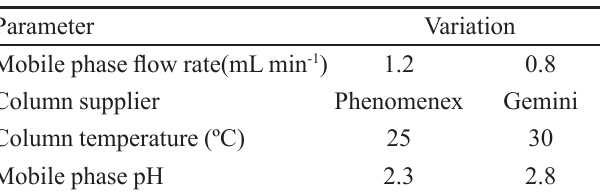
TABLE II - Analytical parameters and variations to evaluate the robustness of the chromatographic method for